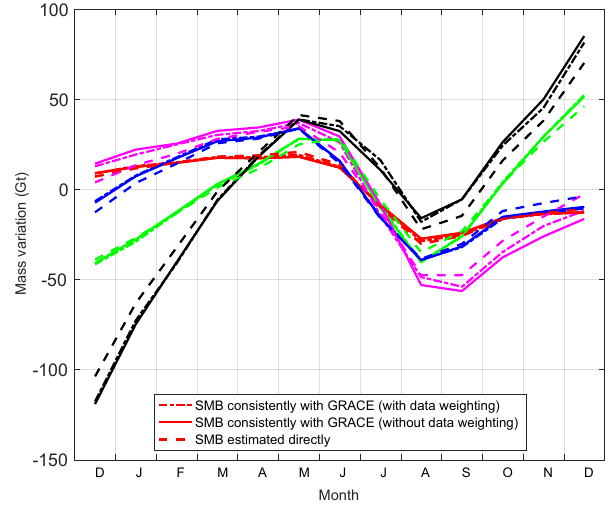
Figure 4. Similar to Fig. 3, but only for mean annual cycle of cu- mulative SMB anomalies of different drainage systems (SE: black; NW: green; NE: blue; N: red; SW: pink). The SMB outputs are computed in three different ways: (i) consistently with GRACE data (with or without data weighting) and (ii) by a direct estimation of mass anomalies per drainage